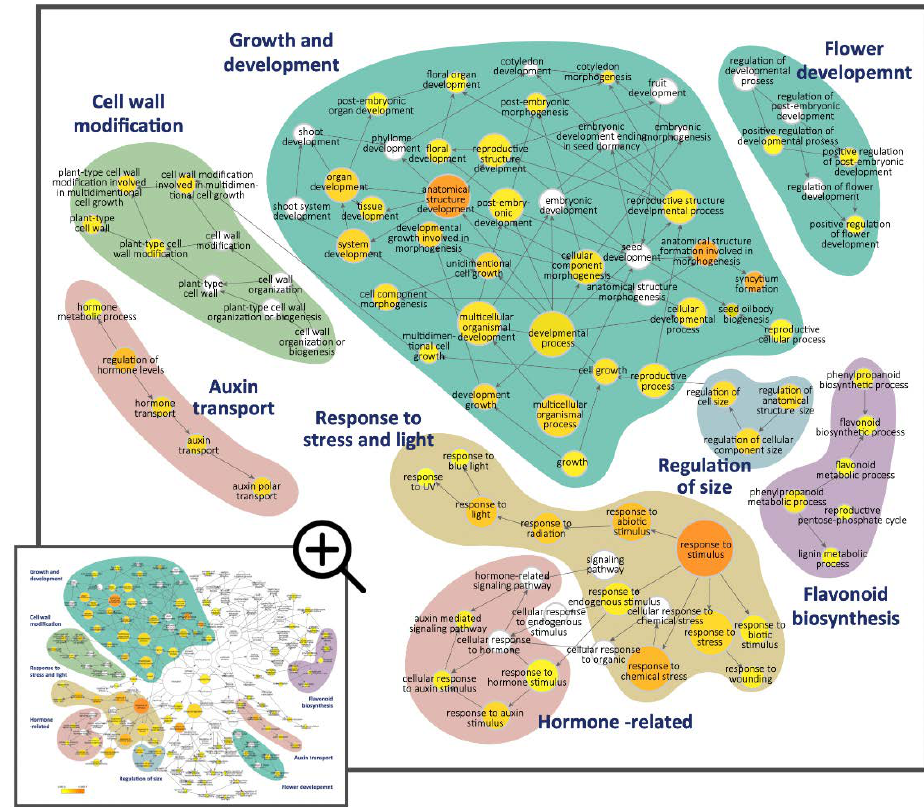
Figure 3. The Gene Ontology (GO) enrichment analysis for the significantly enriched GO terms belonging to the ‘biological process’ GO category for the 630 DV-DEGs in S. speciosa ‘ES’. Node size is proportional to the number of genes, and the color scale represents the significance levels: white, no significant difference; yellow, p -value < 5 × 10 −2 ; orange, p -value < 5 × 10 −7 . Color shadings refer to the GO terms that relate to six broad biological functions. Arrows indicate connections between GO annotations.